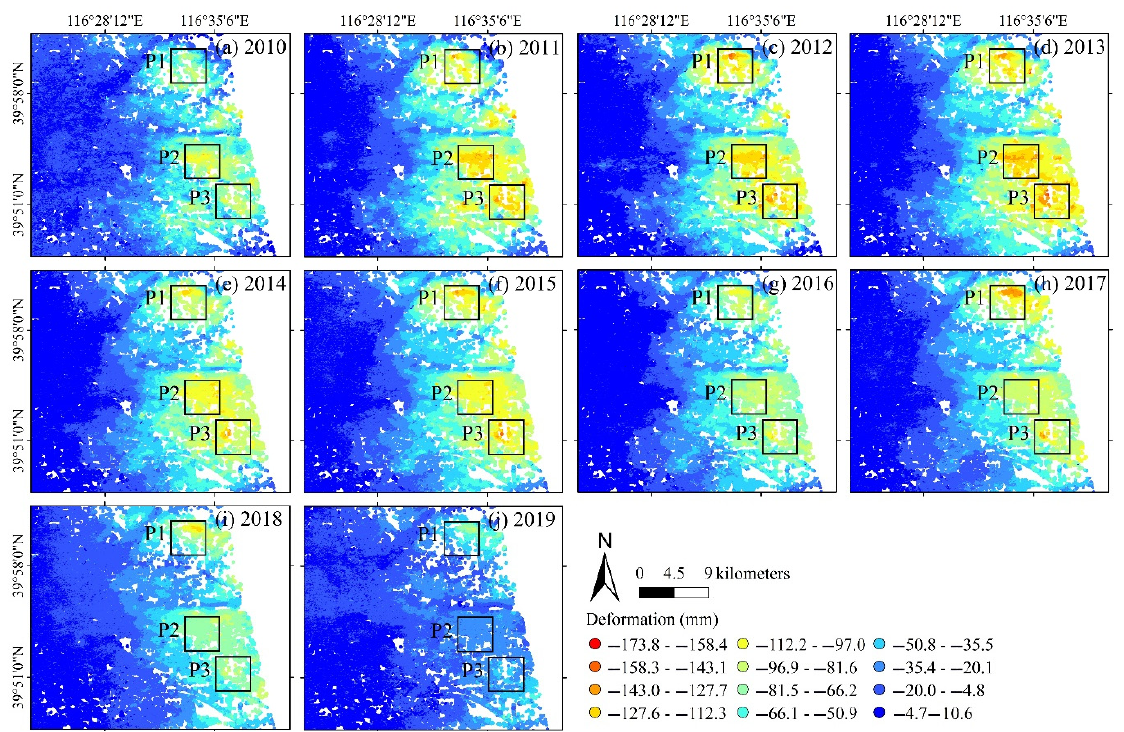
Figure 9. Deformation at different stages derived from PS-InSAR of TerraSAR-X stripmap images between April 2010 and December 2019.